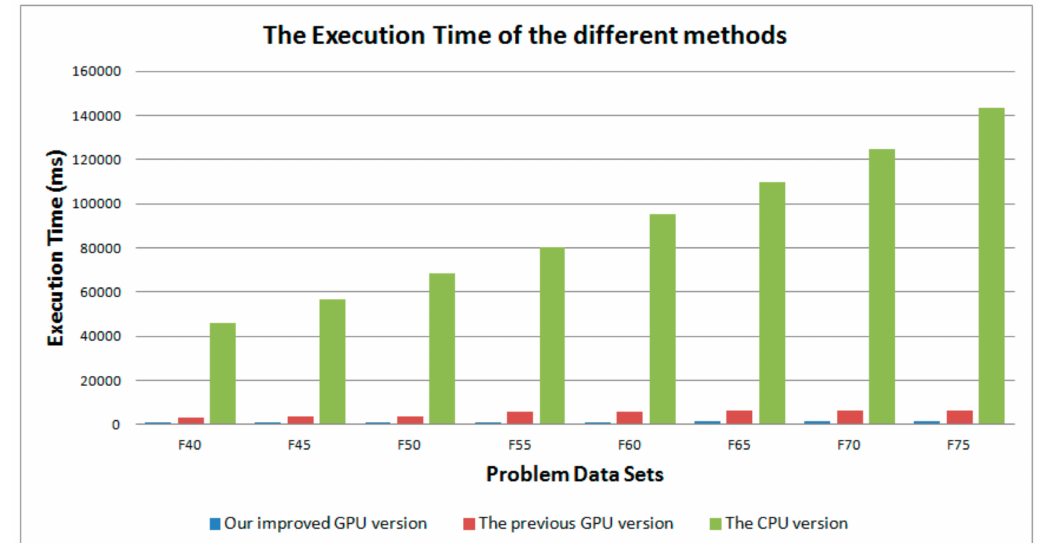
Figure 16. Execution times of the different methods.